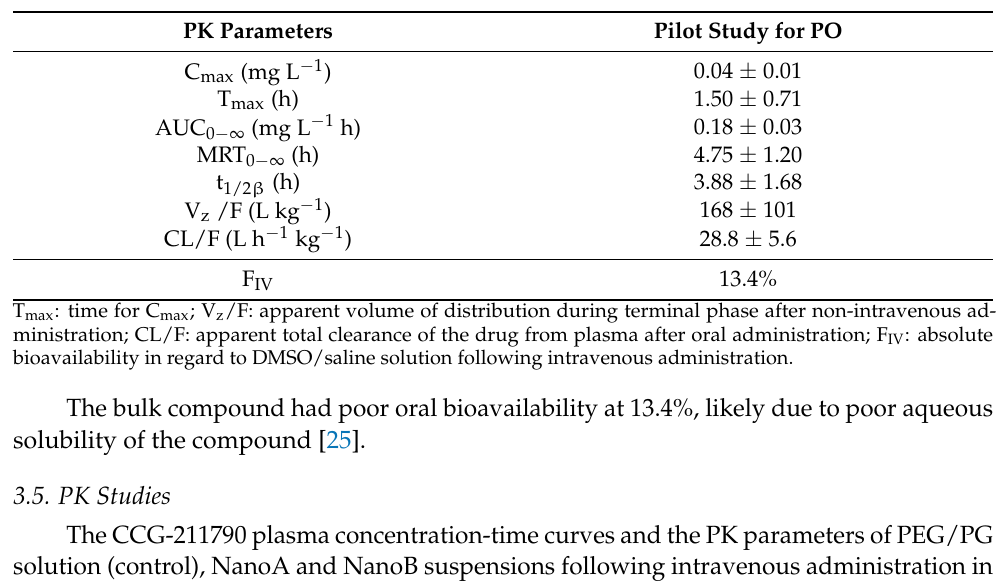
Table 4. Pharmacokinetic parameters of CCG-211790 powder suspension following oral administra- tion at a dose of 5 mg/kg in male Sprague–Dawley rats ( n = 2).